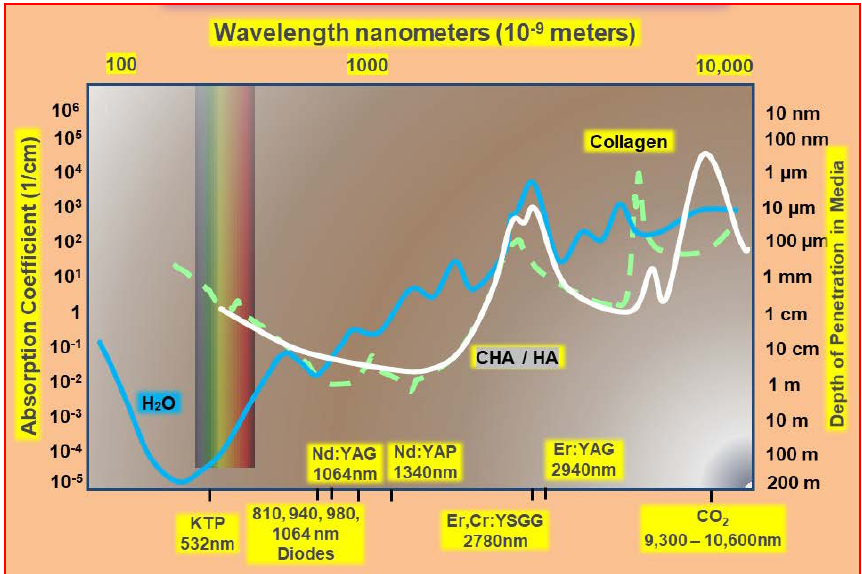
Figure 3. Absorption spectral profiles curves of major tissue elements associated with bone and dental hard tissue management. Absorbance is shown relative to wavelength of irradiation. Key: water (blue), protein / collagen (green), hydroxyapatite—HA and carbonated HA (white). Original data and graphics: Parker S. Data source: Parker, S; et al. Laser Essentials for the Dental Practitioner: